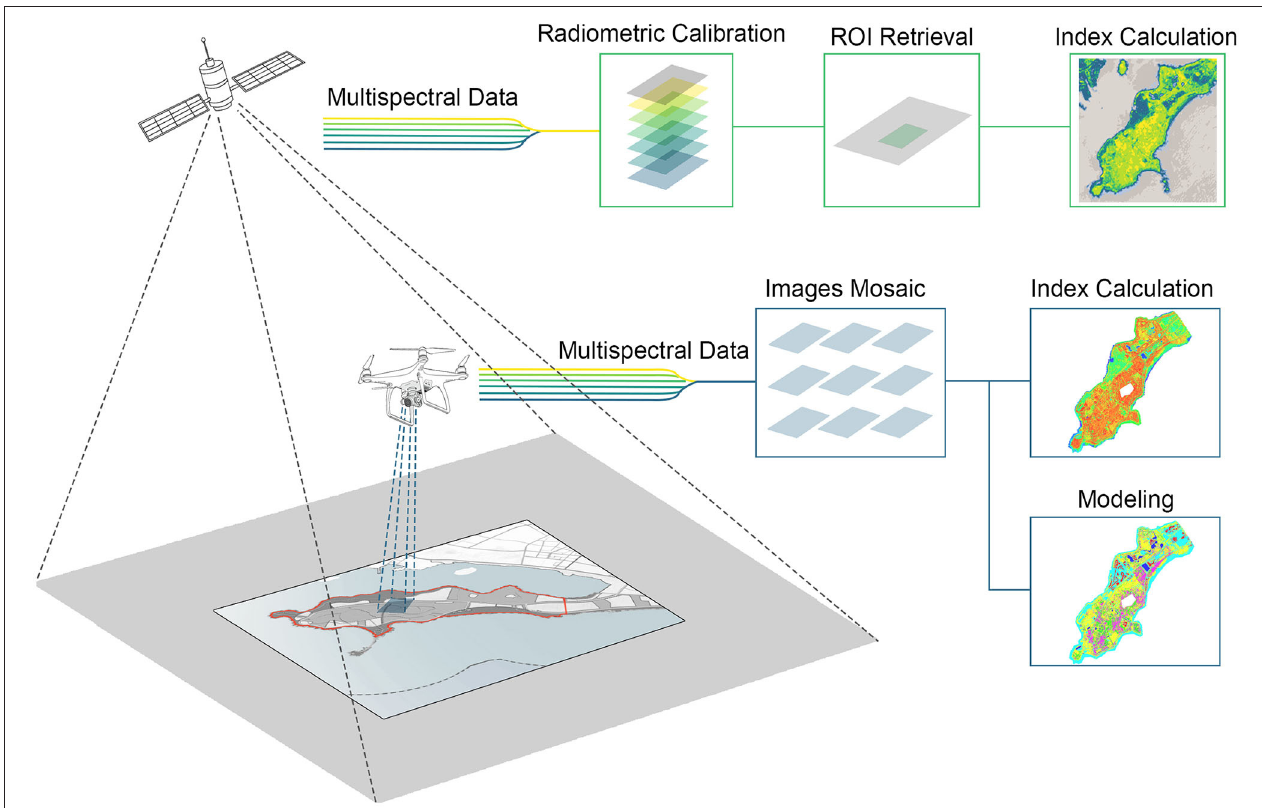
FIGURE 3 | The process of remote sensing (RS) data